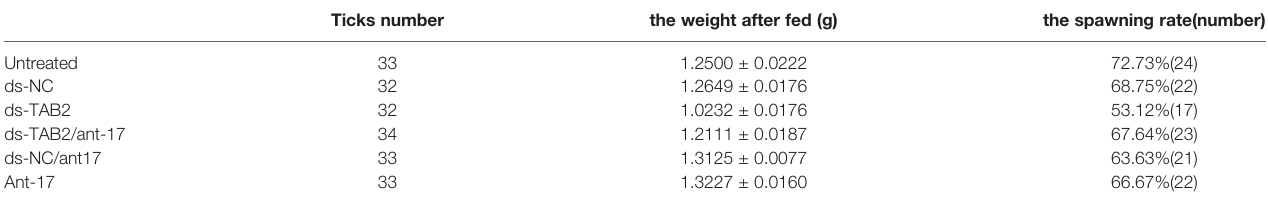
TABLE 5 | Physiological index of ticks in the phenotype rescue experiments. Ticks number the weight after fed